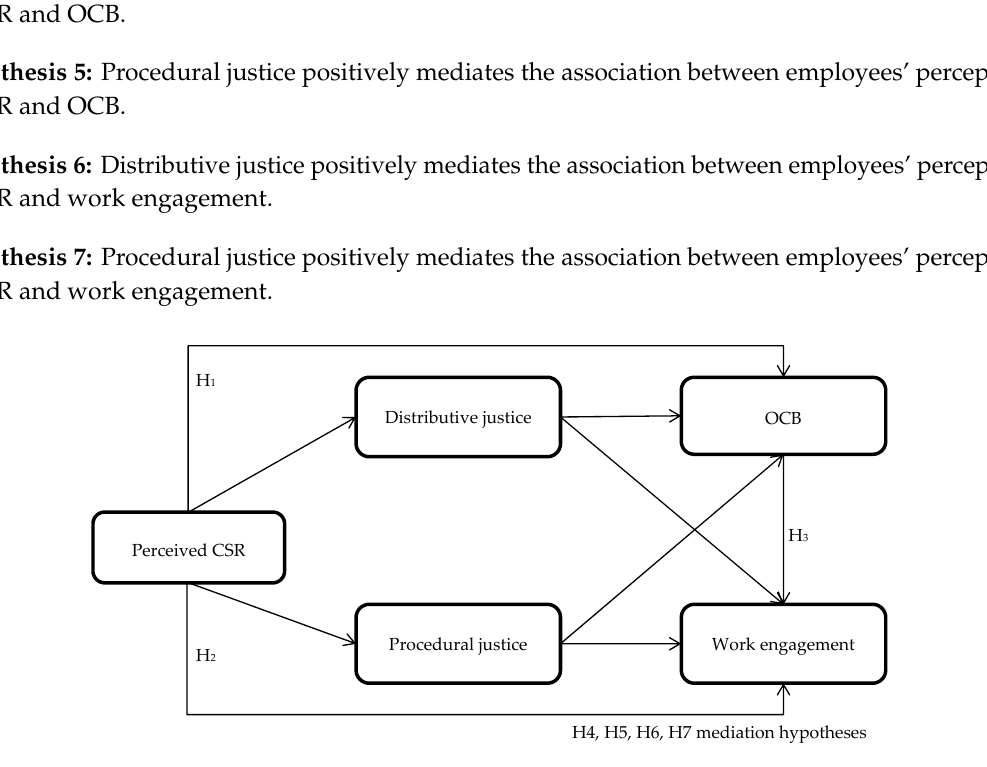
Figure 1. Proposed framework of the study. CSR, corporate social responsibility; OCB, organizational citizenship behavior.